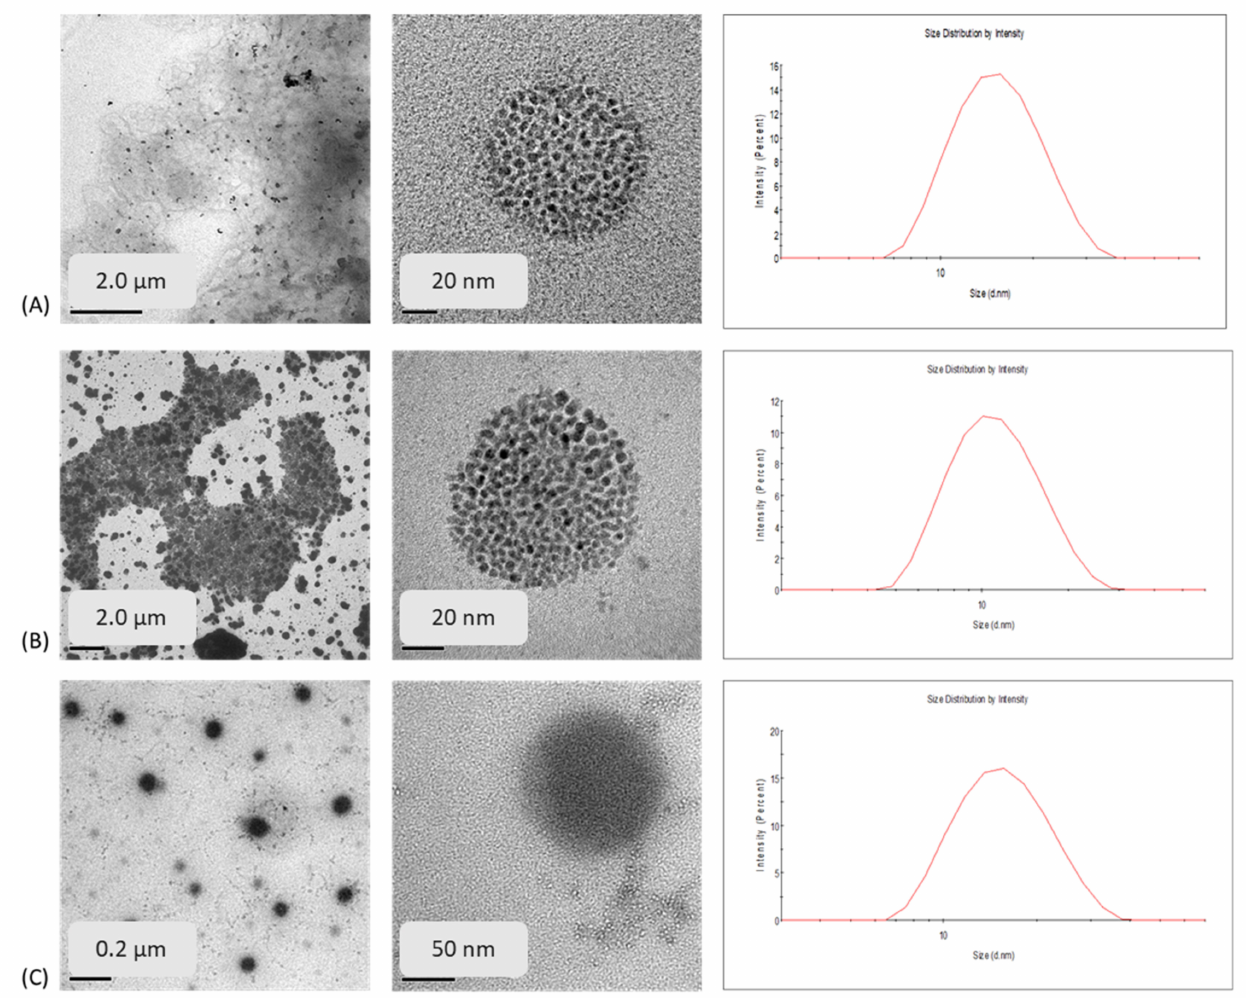
Figure 3. HR-TEM images and size distribution histogram of ( A ) CUR-NP, ( B ) DMC-NP, and ( C )